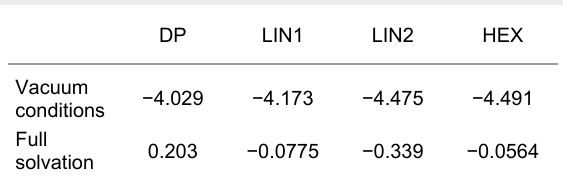
Table 2: Compass adsorption energy of 3,3 ′ -BTP per molecule in different surface structures in electronvolts (eV) at the gas/solid inter- face and free enthalpy of adsorption at the liquid/solid interface at 298